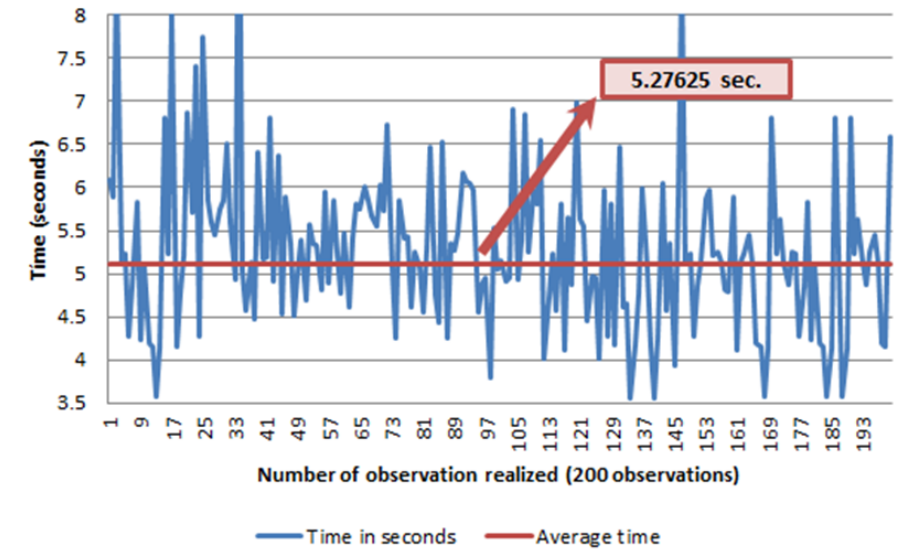
Figure 10. Average time with the Bookreader 2 model.